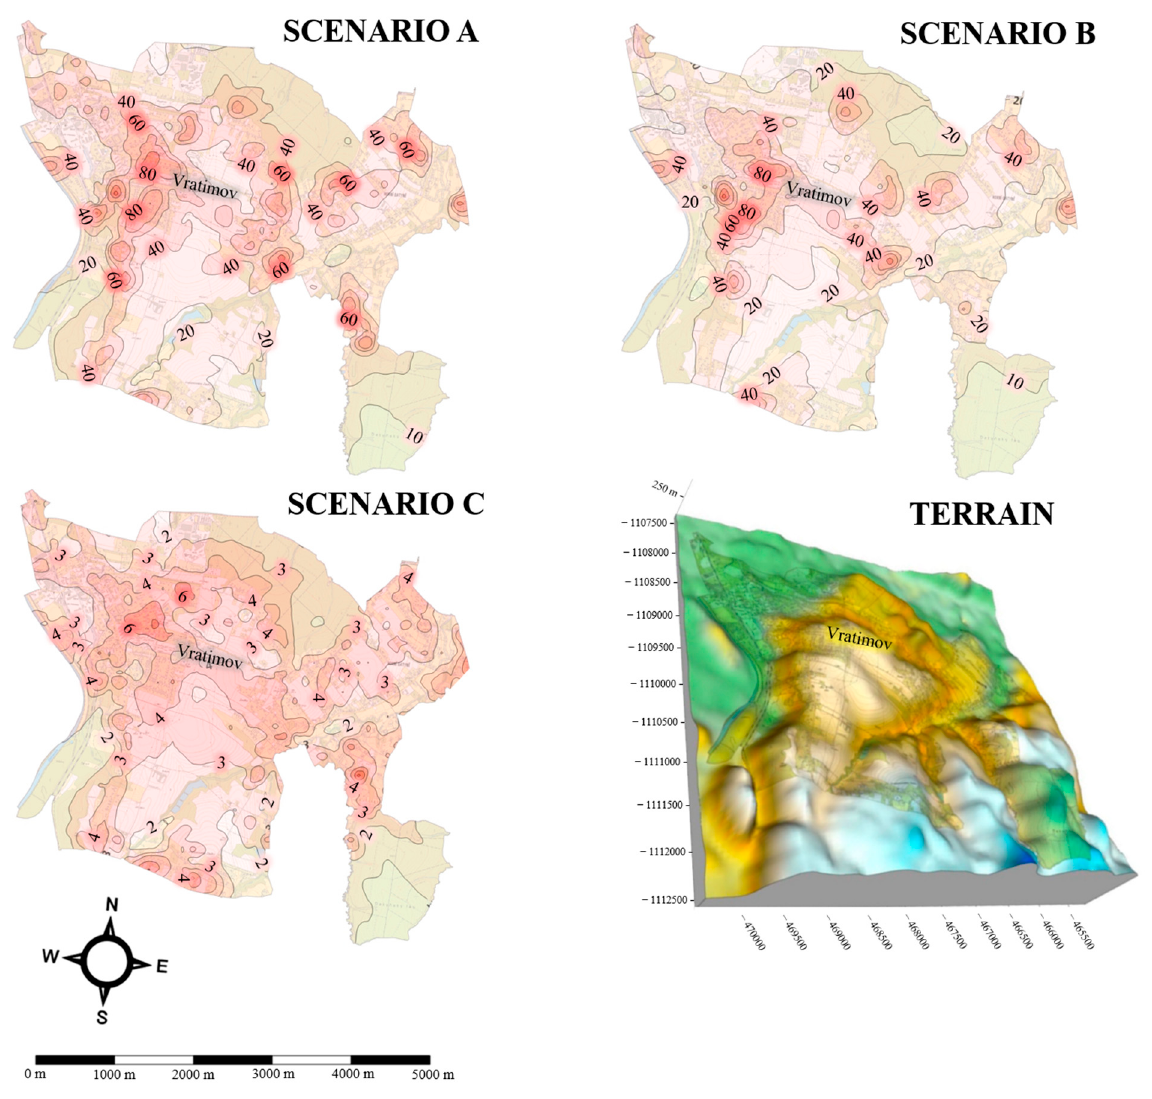
Figure 4. Particulate emissions dispersion model for the location Vratimov.